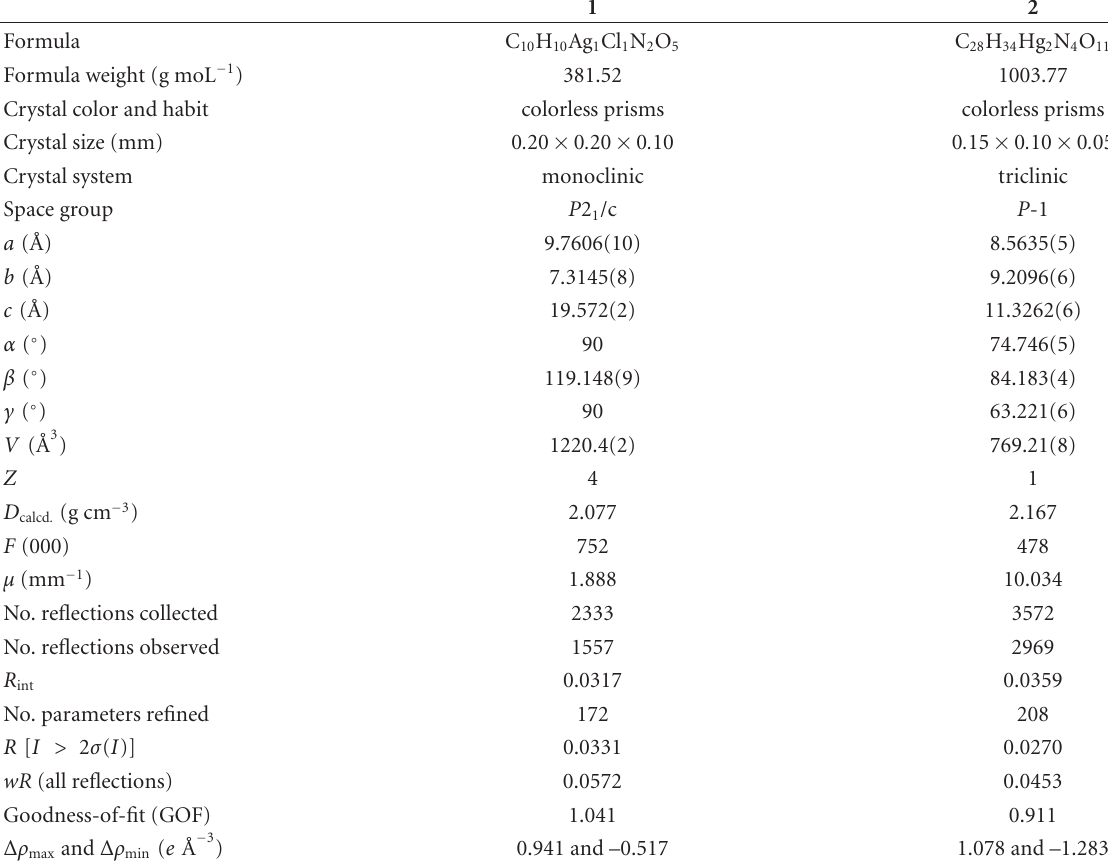
Table 1: Crystallographic data for compounds { [Ag(3,3 (cid:2) -bpy)](ClO 4 ) · H 2 O } n (1) and [Hg(3,3 (cid:2) -bpy)(CH 3 COO) 2 ] 2 · 3H 2 O (2)